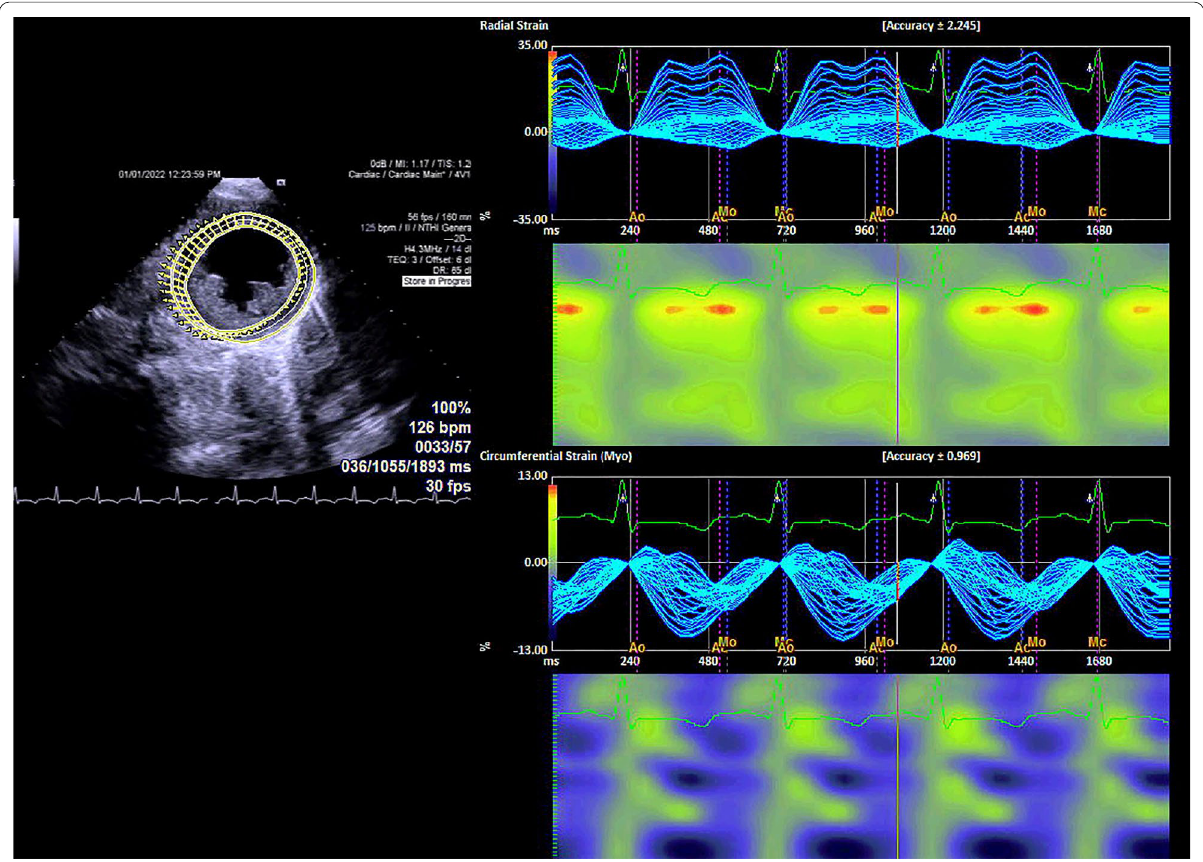
Fig. 5 Left ventricular radial and circumferential strain imaging of the